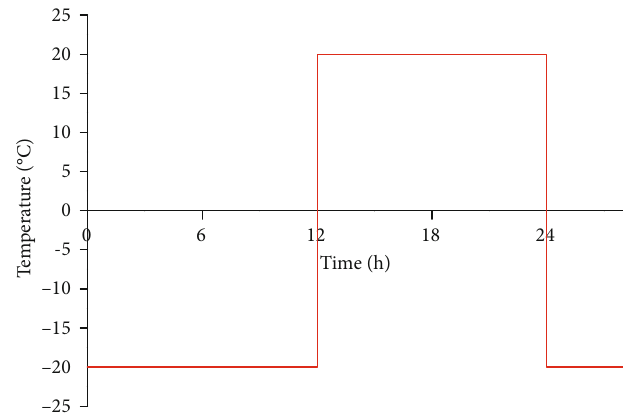
Figure 3: Temperature curve of a freeze-thaw cycle.